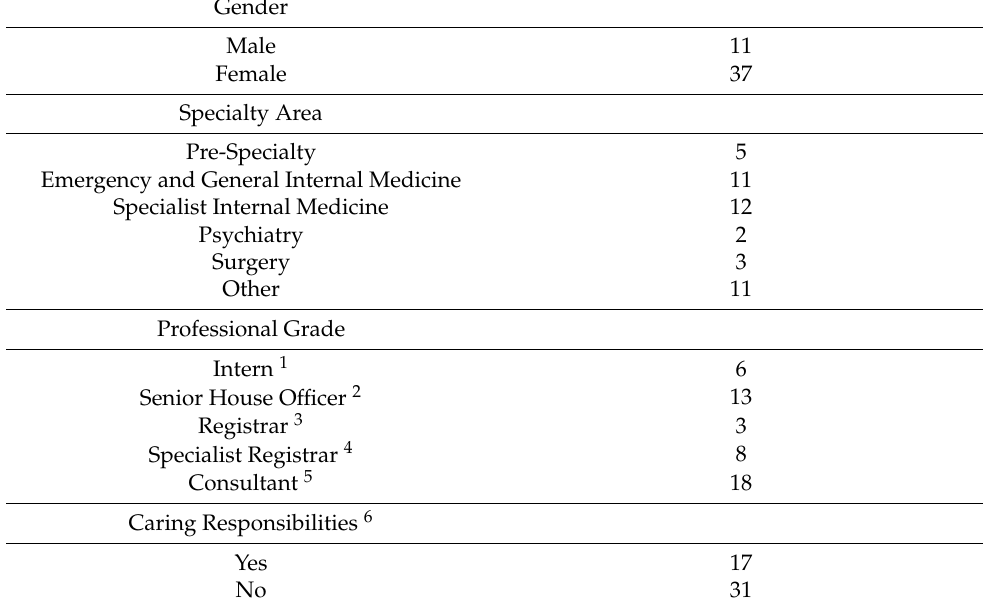
Table 1. Interviewee Profile ( n =